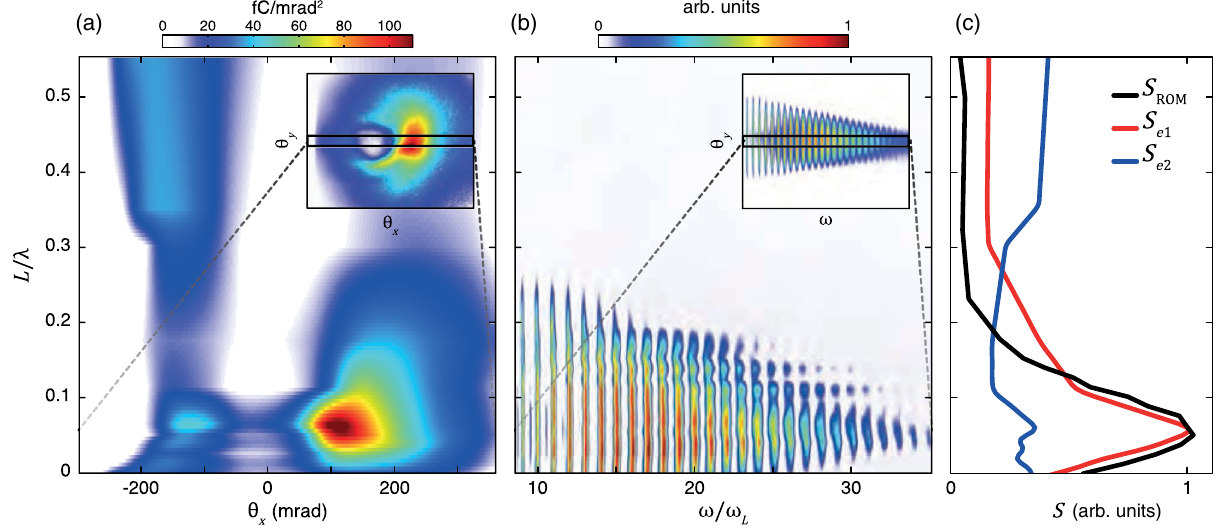
FIG. 3. Evolution of the experimental observables with the density gradient scale length. The angular profile of the relativistic electron beam in the incidence plane (a) and the emitted harmonic spectrum (b) are plotted as a function of L , for a p -polarized laser field. The experimental parameters are the same as in Fig. 2. The insets show how these quantities are related to the images of Fig. 2 (note that these insets do not hide any relevant signal). Panel (c) shows different curves derived from these datasets: the harmonic signal integrated from the 20th to the 25th order (signal S ), and the electron signals on the right-hand ( 50 ≤ θ x ≤ 150 mrad, signal S e 1 ) and left-hand sides ROM ( − 250 ≤ θ x ≤ − 150 mrad, signal S e 2 ) of the specular direction, are plotted as a function of L . These curves show the transition between the two regimes highlighted in Fig. 2, and reveal the quantitative correlation between the harmonic and relativistic electron signals for short-gradient scale